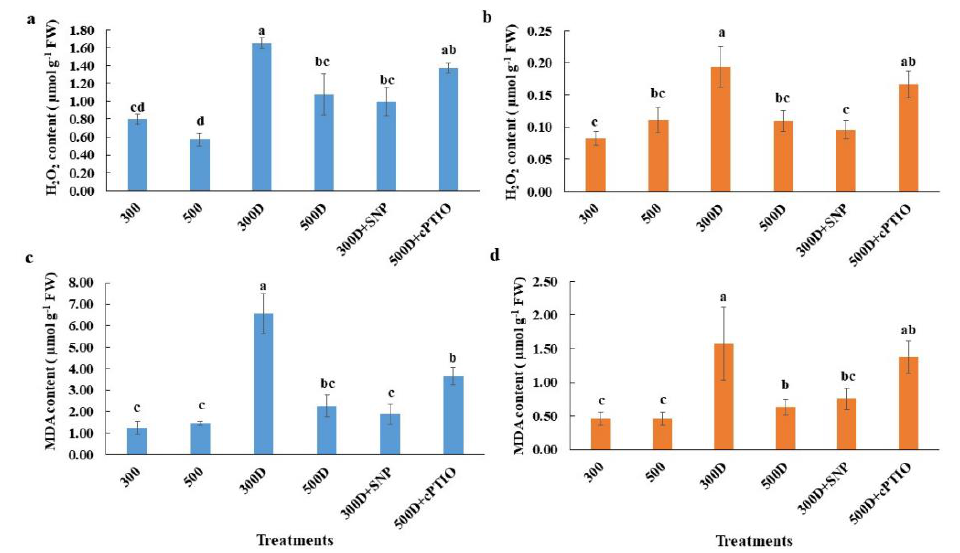
Figure 7 . Quantitative ROS accumulation and lipid peroxidation responses : quantitative hydrogen peroxide accumulation Figure 7. Quantitative ROS accumulation and lipid peroxidation responses: quantitative hydrogen in ( a ) leaves and ( b ) roots, and malondialdehyde ( MDA ) content of ( c ) leaves and ( d ) roots of rice plants after 3 - day growth peroxide accumulation in ( a ) leaves and ( b ) roots, and malondialdehyde (MDA) content of ( c ) leaves in the different NO - associated treatments . Values shown are the Mean ± SE ( n = 4 ). The different letters above the bars and ( d ) roots of rice plants after 3-day growth in the different NO-associated treatments. Values indicate significant differences by one - way ANOVA and Duncan’s test ( P ≤ 0 . 05 ). shown are the Mean ± SE (n = 4). The different letters above the bars indicate significant differences by one-way ANOVA and Duncan’s test ( p ≤